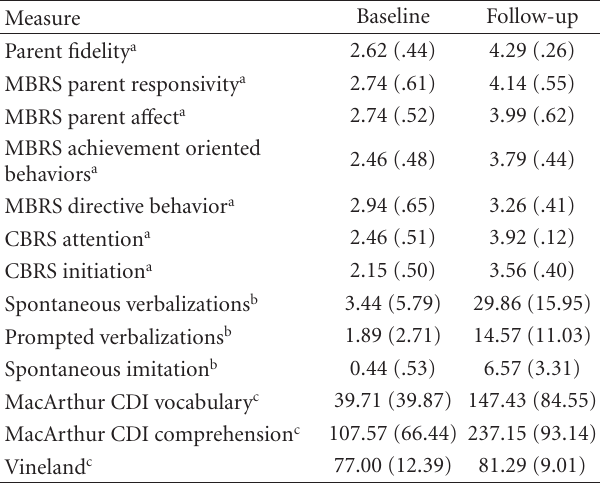
Table 2: Baseline and follow-up measures of